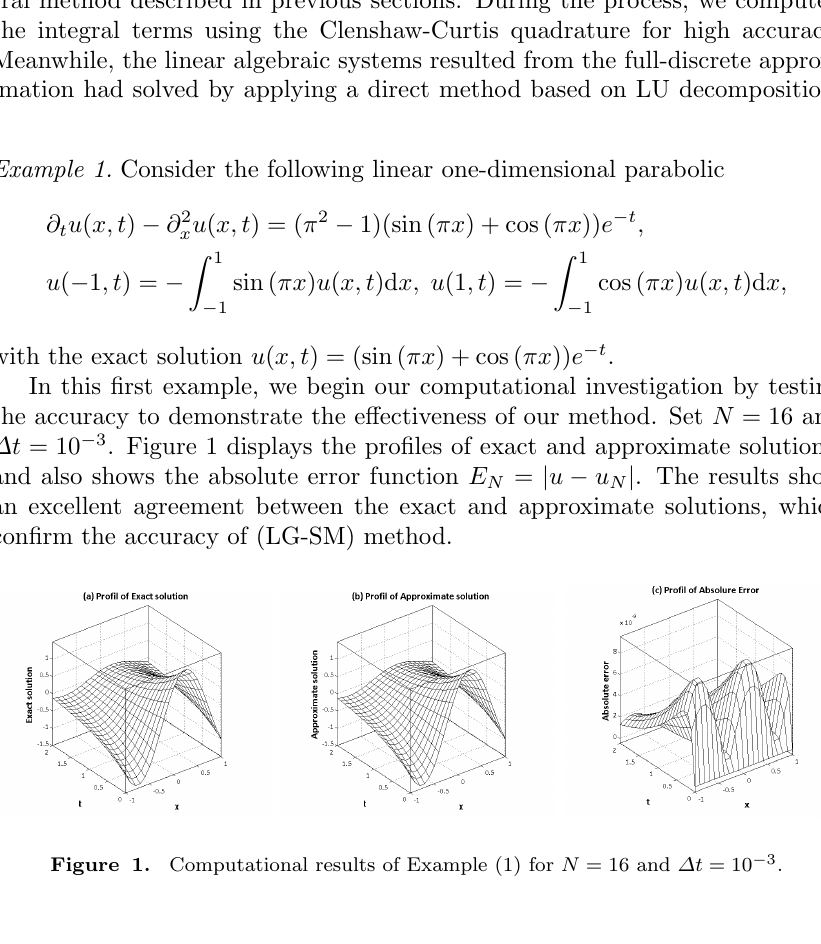
Table 1. Spatial convergence rates at t = 1 for Example 1. N L 2 -error order L ∞ -error